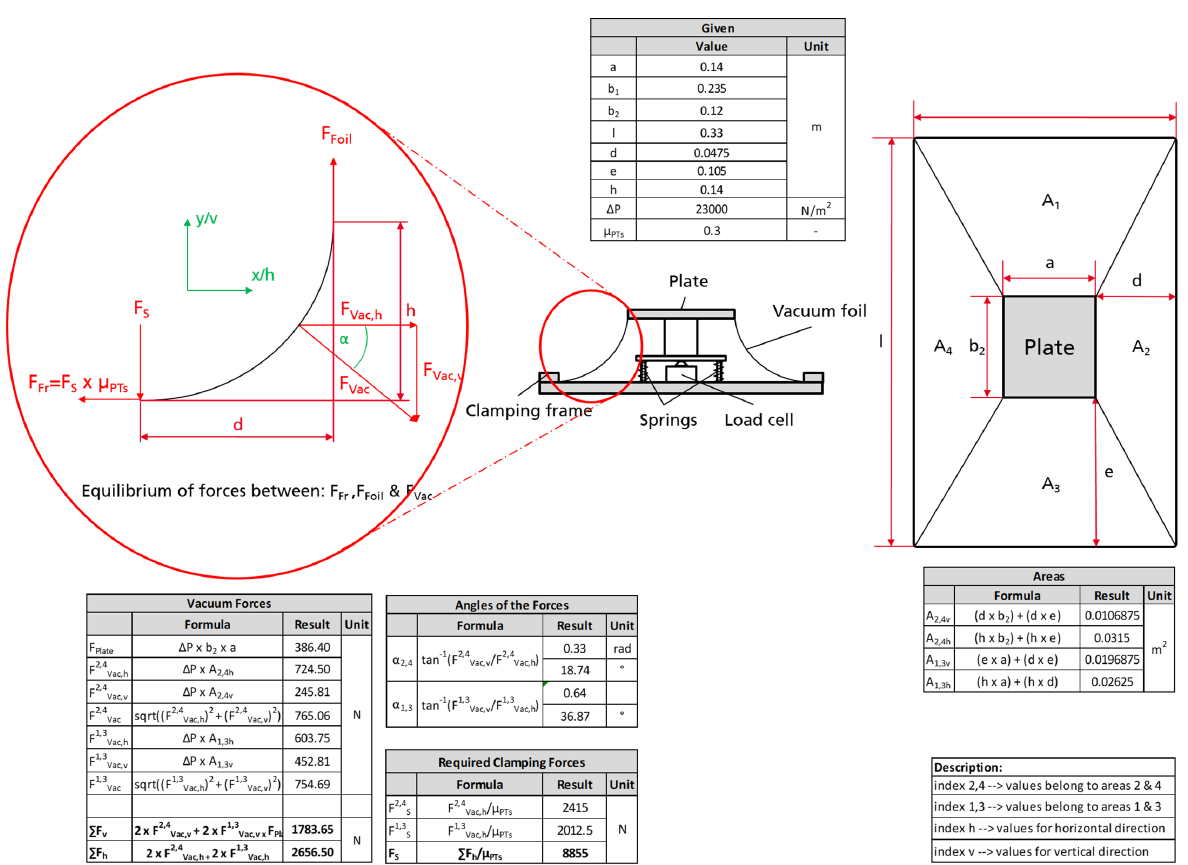
Figure A1. Model for the Calculation of the Necessary Clamping Force.